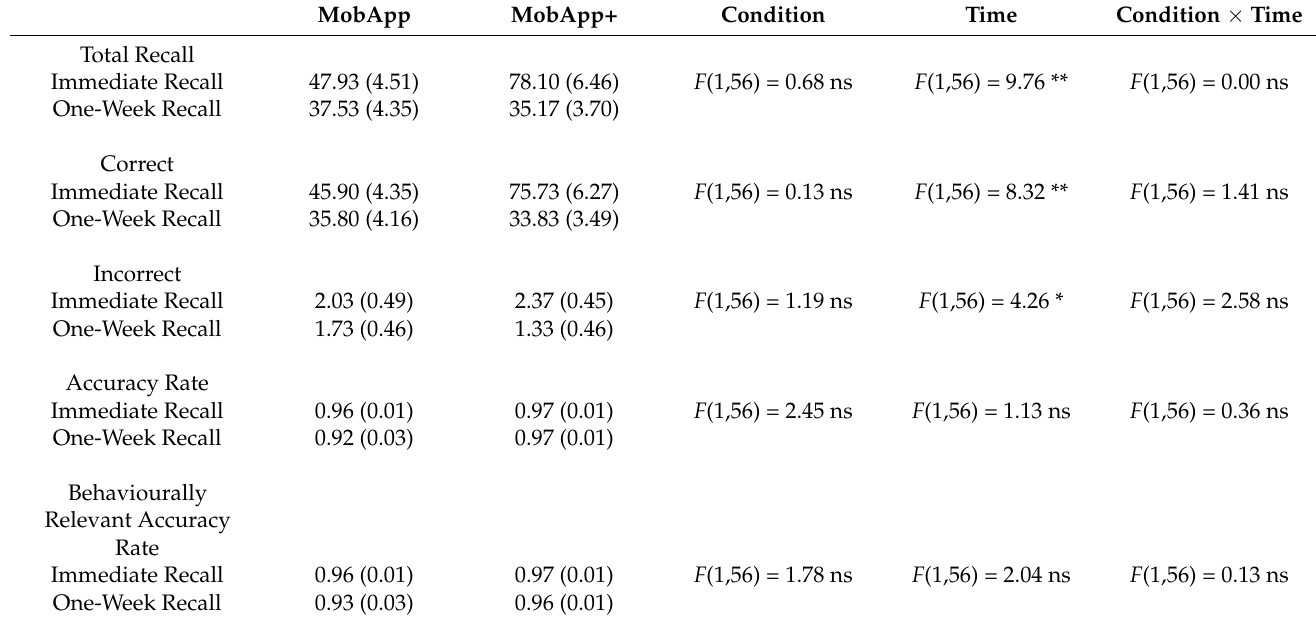
Table 3. Descriptive and Inferential Statistics for Repeated-Measures ANCOVAs on each of the Dependent